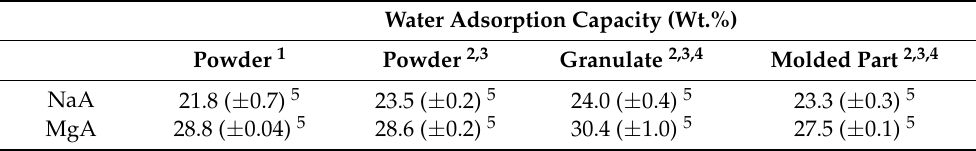
Table 6. Water adsorption capacity of the NaA and MgA zeolite samples and their associated composite forms at 30 ◦